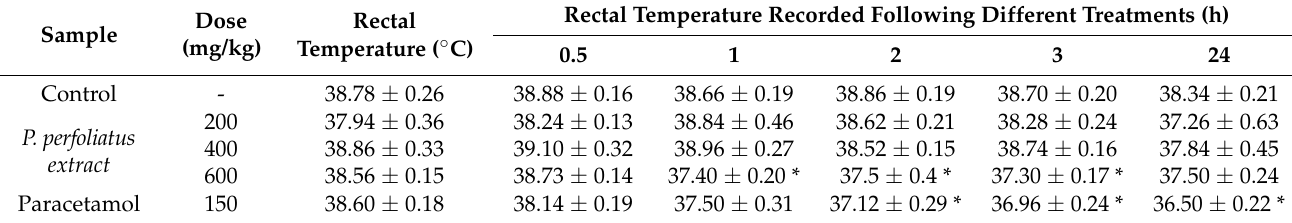
Table 3. Results from P. perfoliatus extract on Brewer’s yeast-induced pyrexia in mice.